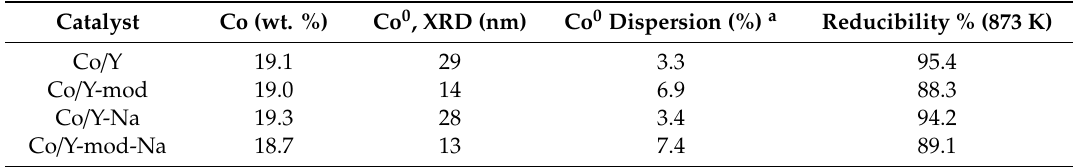
Table 2. Co content, crystal size of metallic Co (XRD), dispersion of metallic Co, and percentage of Co reduced at 873 K (reducibility).